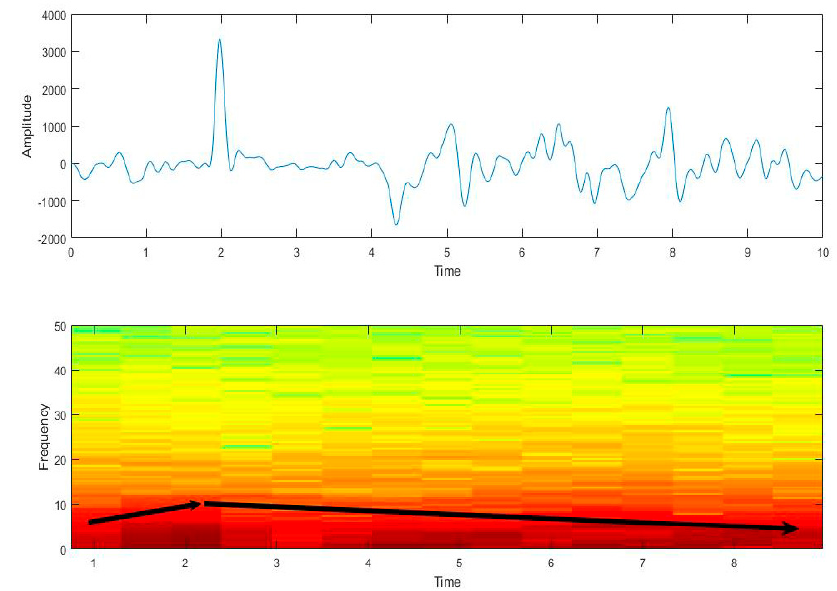
Figure 9. The time-frequency diagram of the airplane vibration signal.